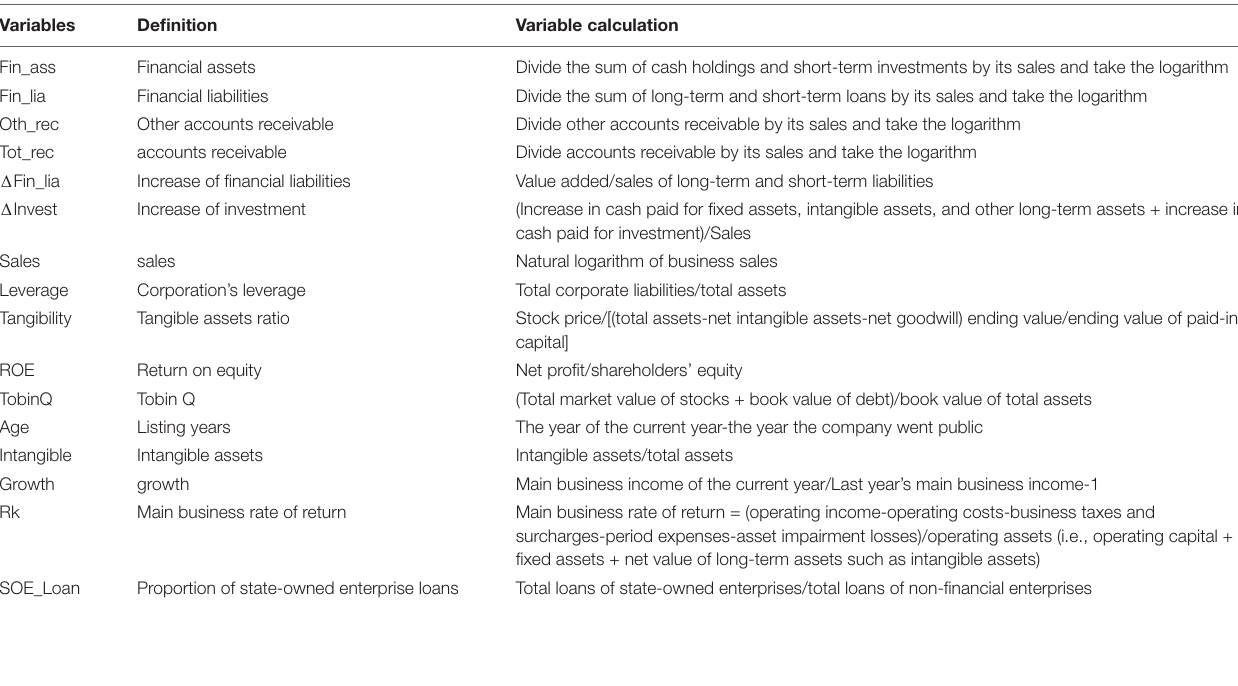
TABLE A1 | Definition and calculation of main